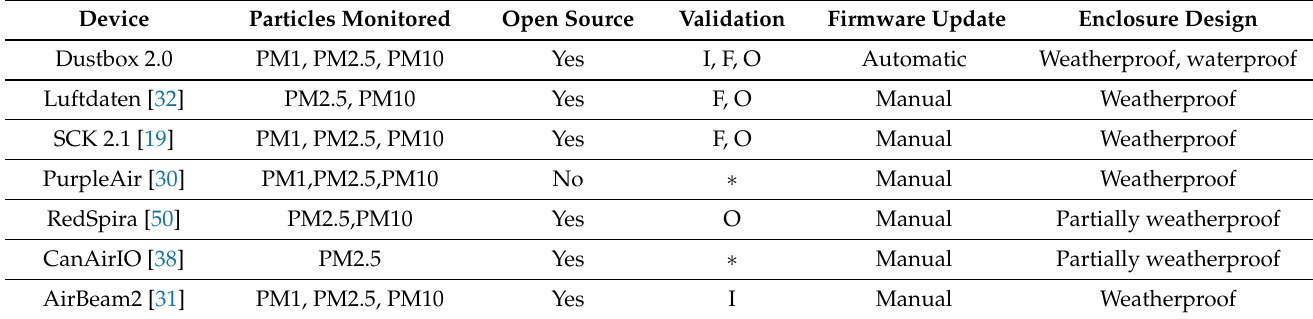
Table 5. Comparison with state of the